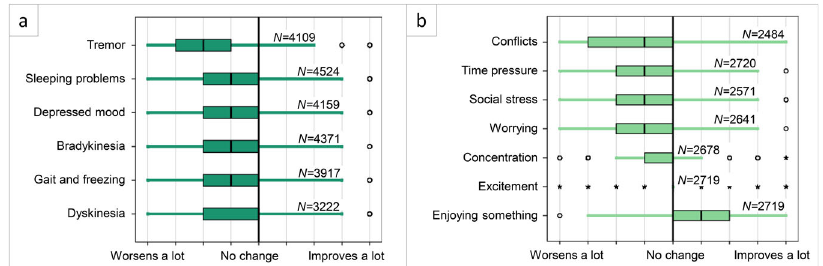
Fig. 2 The effect of stress on Parkinson ’ s symptoms. The change that patients perceive on Parkinson ’ s symptoms during stress (Panel a , fi lled in by all PD responders ( n = 5000)) or due to different types of stressful activities or situations (Panel b , part of the optional survey ( n = 3214)). Both a and b responses were given on a 9-point scale in which 1 stood for severe worsening of symptoms, 5 stood for no change, and 9 for a lot of improvement (represented by the vertical lines). Responses are visualized in a boxplot, in which the box corresponds to 75% of responses and the tails are the remaining 25%, except outliers. Open circles show small outliers and stars show extreme outliers. Vertical lines are answer options on the 9-point scale. All shown effects are signi fi cantly different from “ no change ” , ( p < 0.0083 corrected for Fig. 2a; p < 0.0071 corrected for Fig.